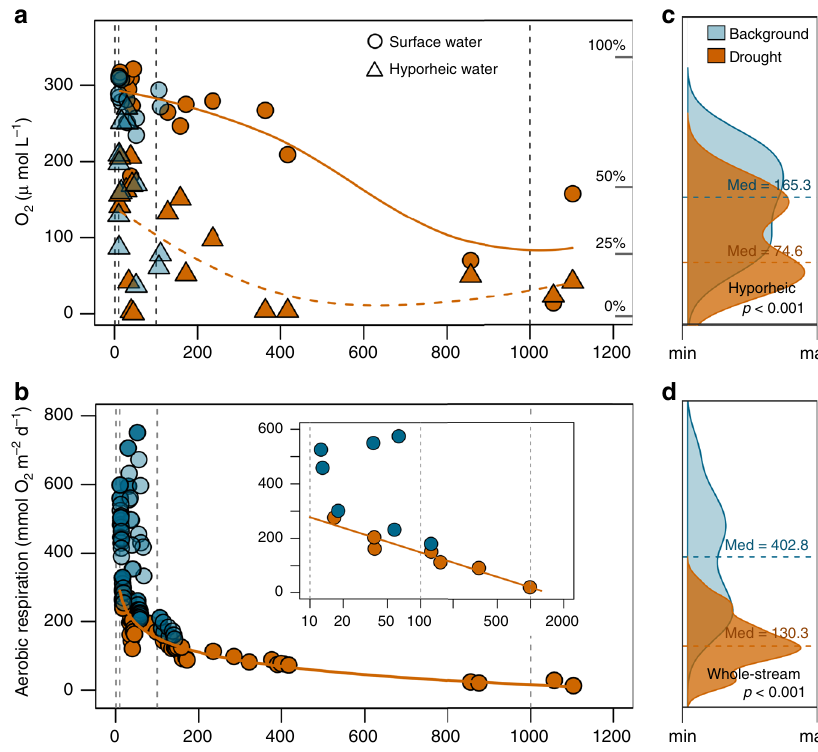
Fig. 2 Experimental drought reduced O 2 availability and aerobic respiration. Relationship between stream water residence time and a , dissolved oxygen (O 2 ) concentration in the stream surface and hyporheic water and b , aerobic respiration measured during the summer 2017 drought experiment. Panels c and d present Kernel density plots for hyporheic O 2 concentration and whole-stream aerobic respiration rates for drought and background (pre- and post drought) observations, respectively. Differences between drought and background conditions were tested using a nonparametric Wilcoxon Signed-Rank test. Orange and blue colors denote drought and background conditions, respectively. Circles and triangles denote surface and hyporheic water observations, respectively. Solid and dashed lines in panel a are locally weighted regression model fi ttings (Loess) for surface and hyporheic water observations, respectively. Solid orange lines in b represent the regression model best fi tting the observations ( r 2 = 0.41; p < 0.001, n = 111). The inset plot in panel b shows the segment-averaged aerobic respiration rates along a log-transformed x